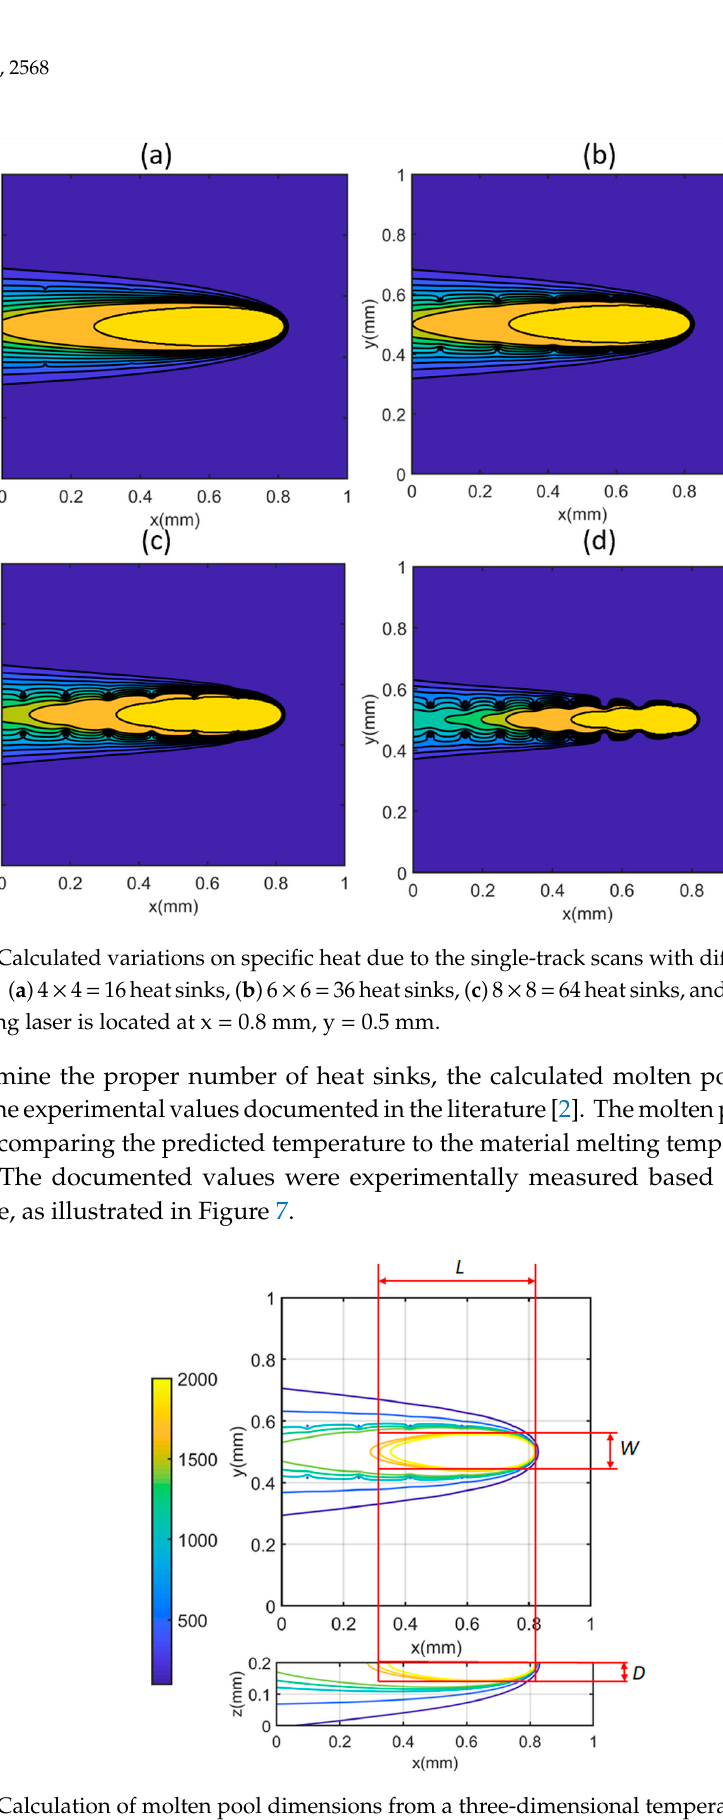
Figure 4. Calculated variations on thermal conductivity due to the single-track scans with different numbers of heat sinks: ( a ) 4 × 4 = 16 heat sinks, ( b ) 6 × 6 = 36 heat sinks, ( c ) 8 × 8 = 64 heat sinks, and